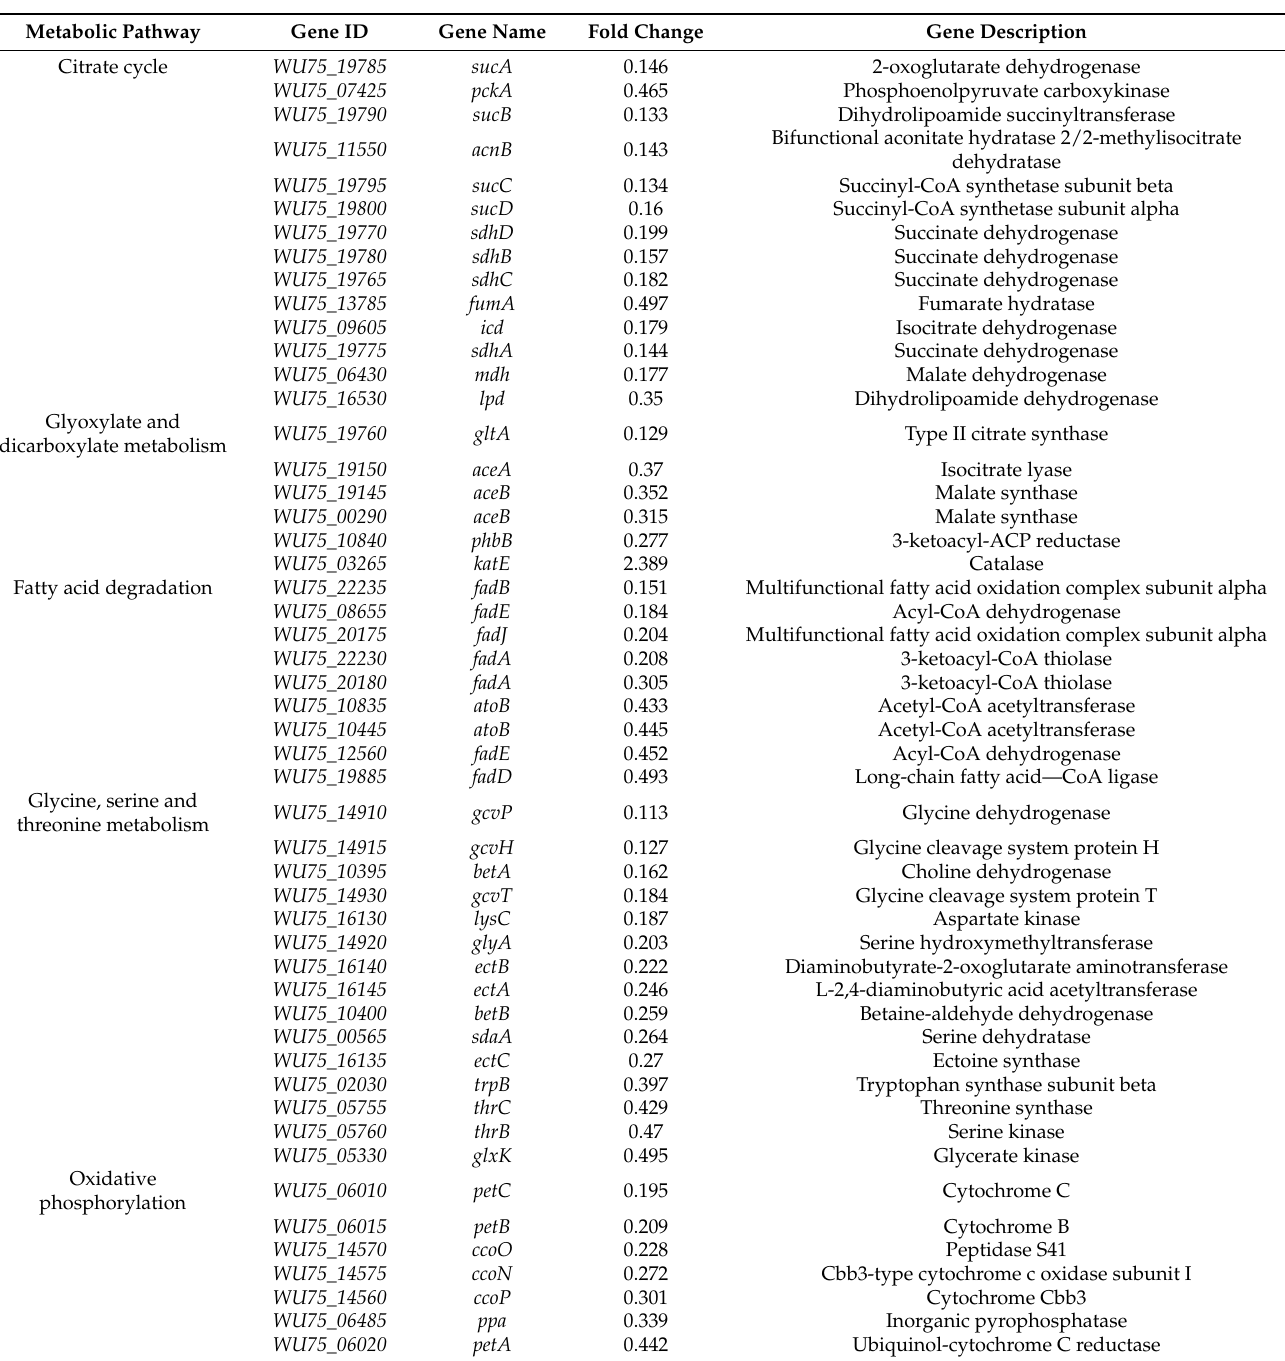
Table 4. The major altered metabolic pathways in V. parahaemolyticus